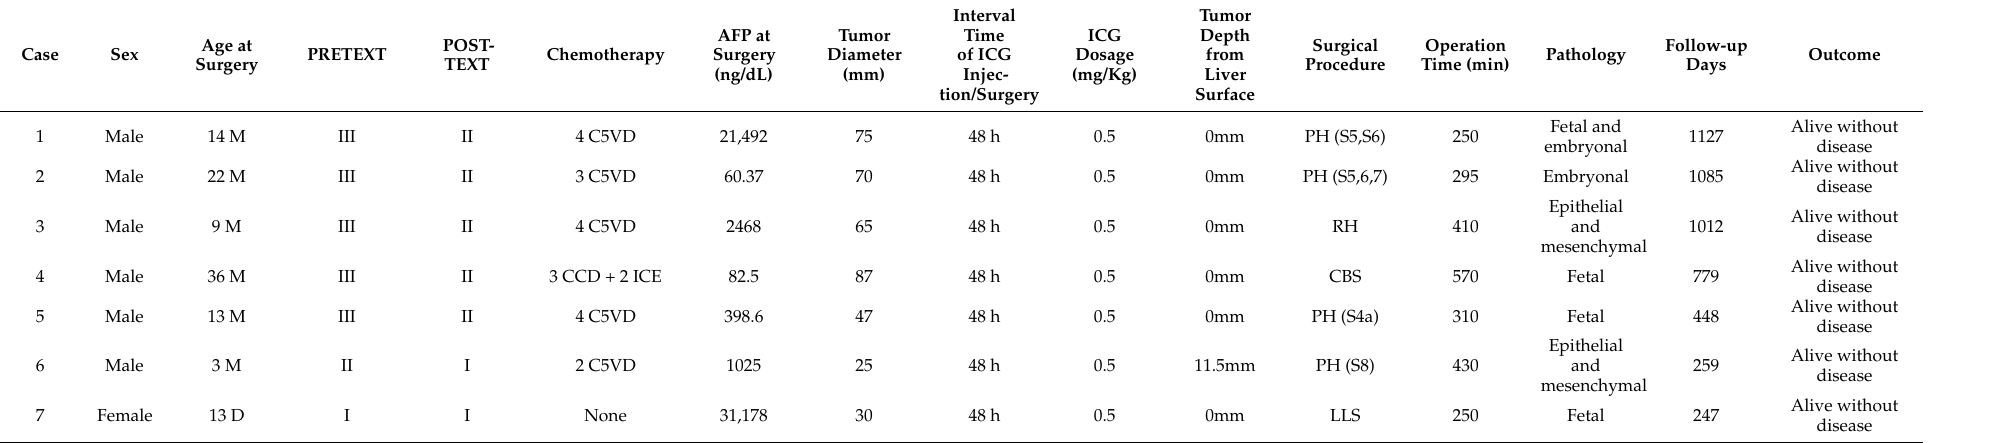
Table 1. Clinical, pathological, and surgical data of seven children who underwent ICG fluorescence-guided laparoscopic HB